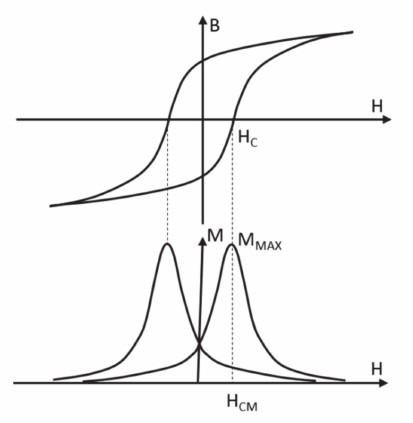
Figure 1. Schematical view of a hysteresis curve ( top ) and the envelope of the Barkhausen noise signal ( bottom